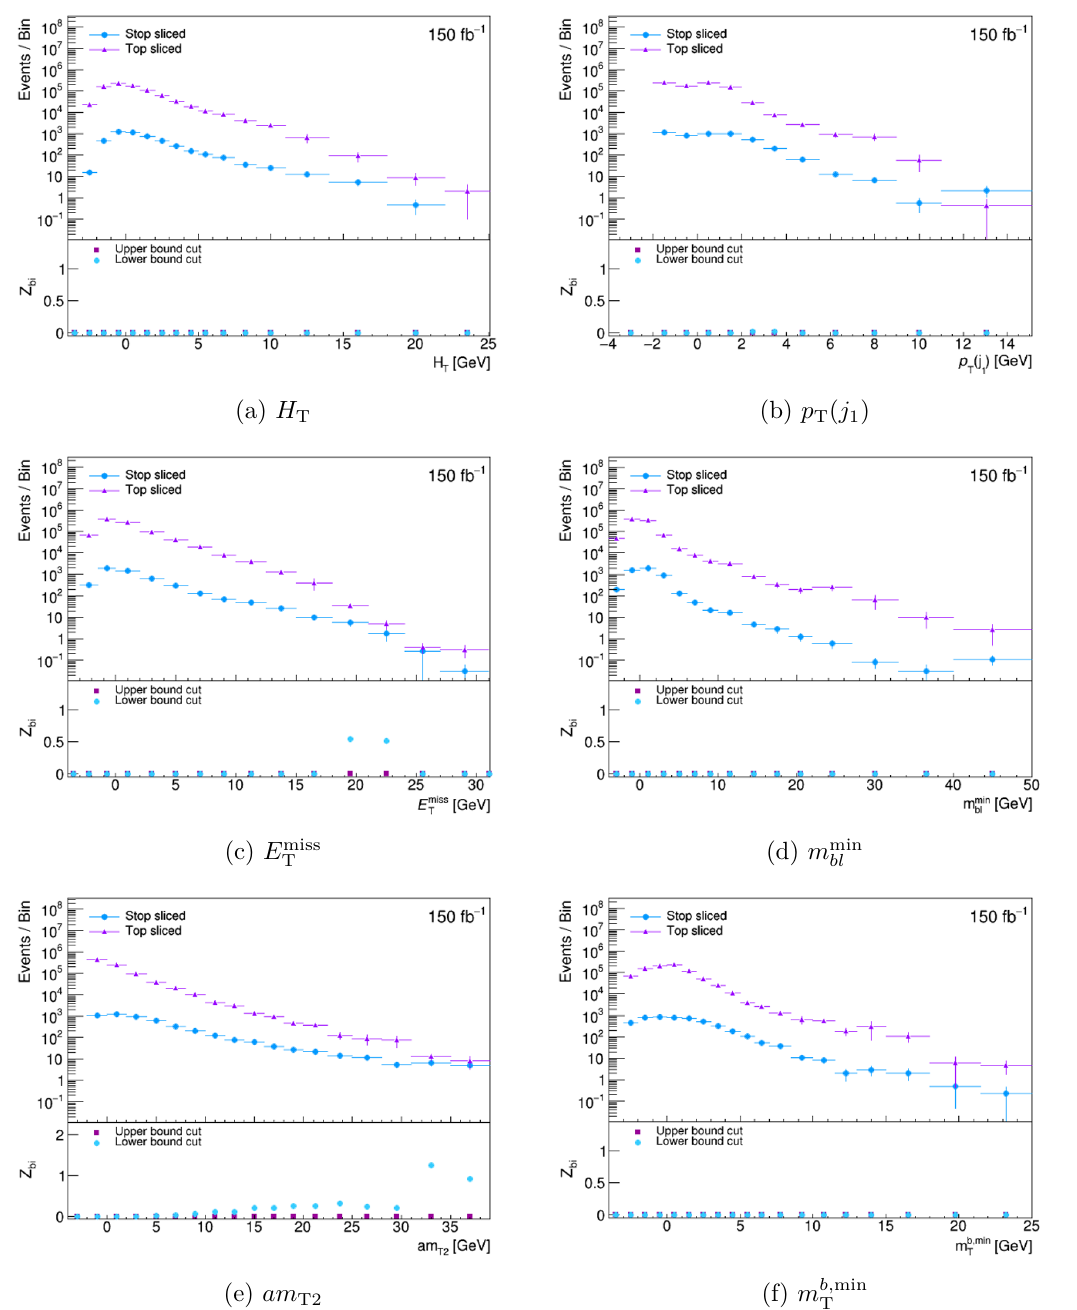
Figure 7. Event rates as functions of the kinematic variables for the stop simplified model example that show the most difference between the signal and the background. Each variable has been scaled by the “background median” procedure described in the text. Events in the overflow bin are not shown in the distribution but are included in the Z bi